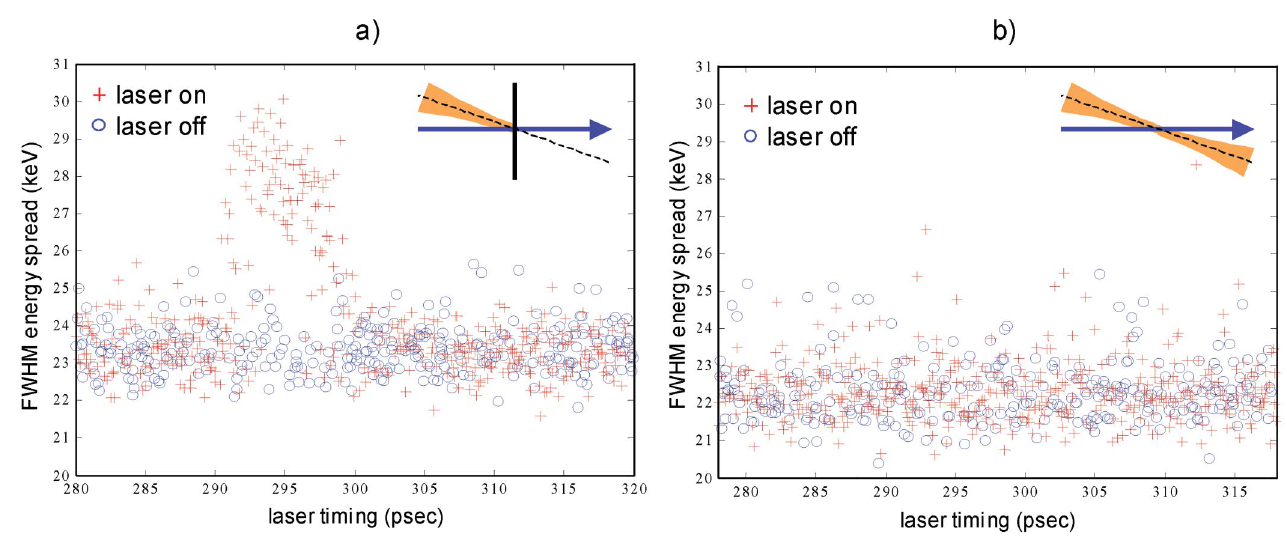
FIG. 10. (Color) The effect of the field-terminating